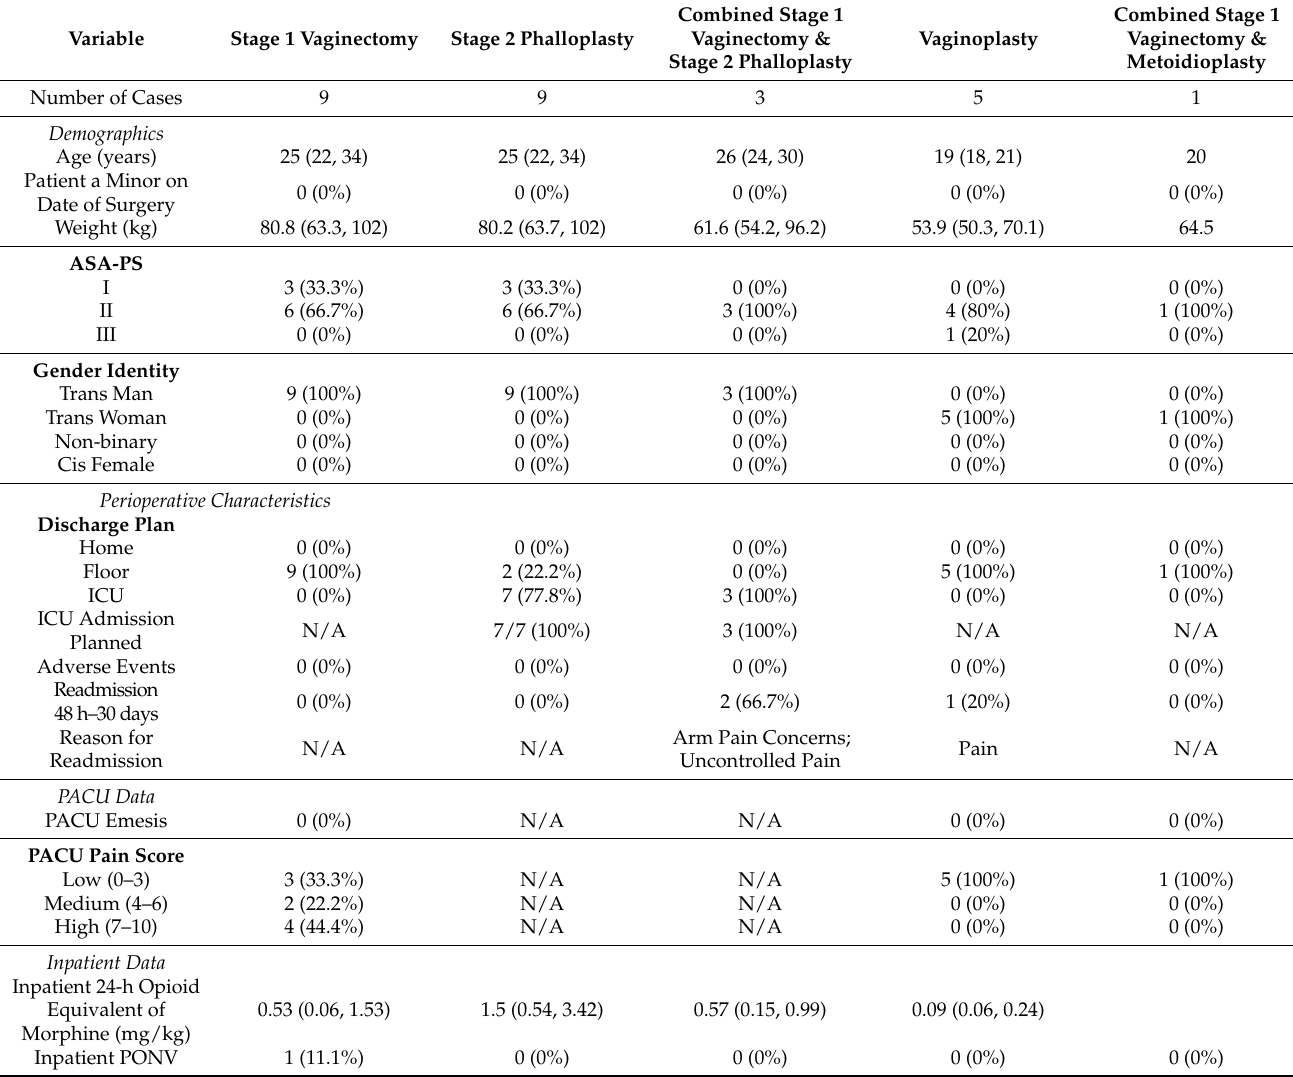
Table 3. Genital Surgeries in the Three-Year Case Series at the Center for Gender Surgery